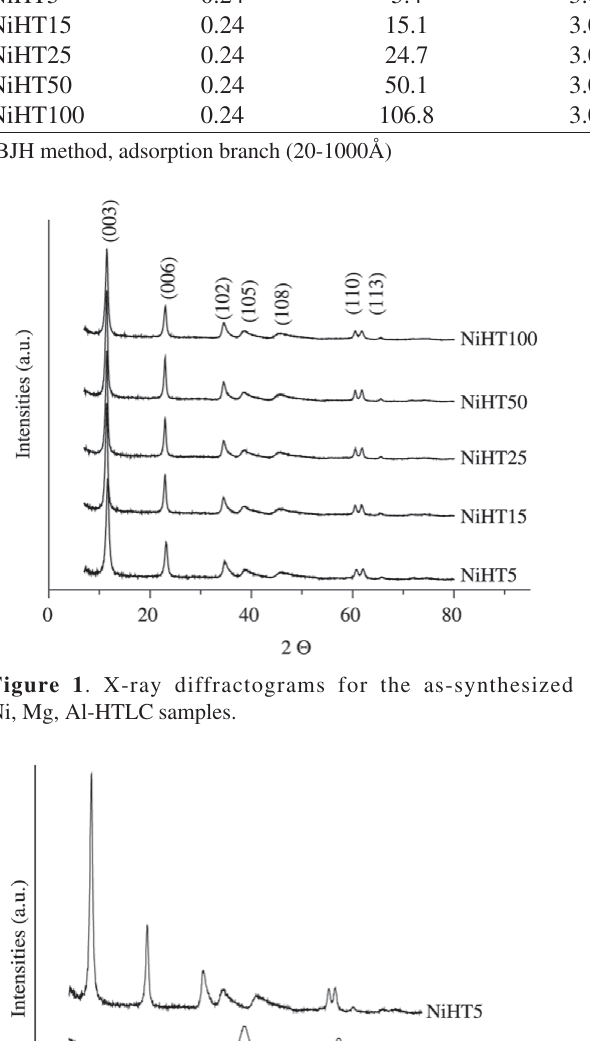
Table 1 . Chemical composition and structural characteristics of the as-synthesized samples. Sample